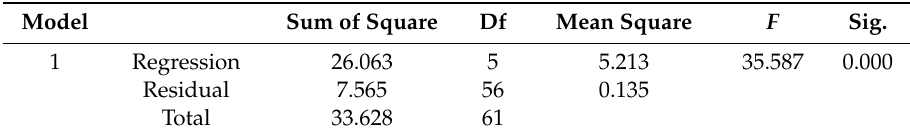
Table 6. ANOVA statistics of regression.